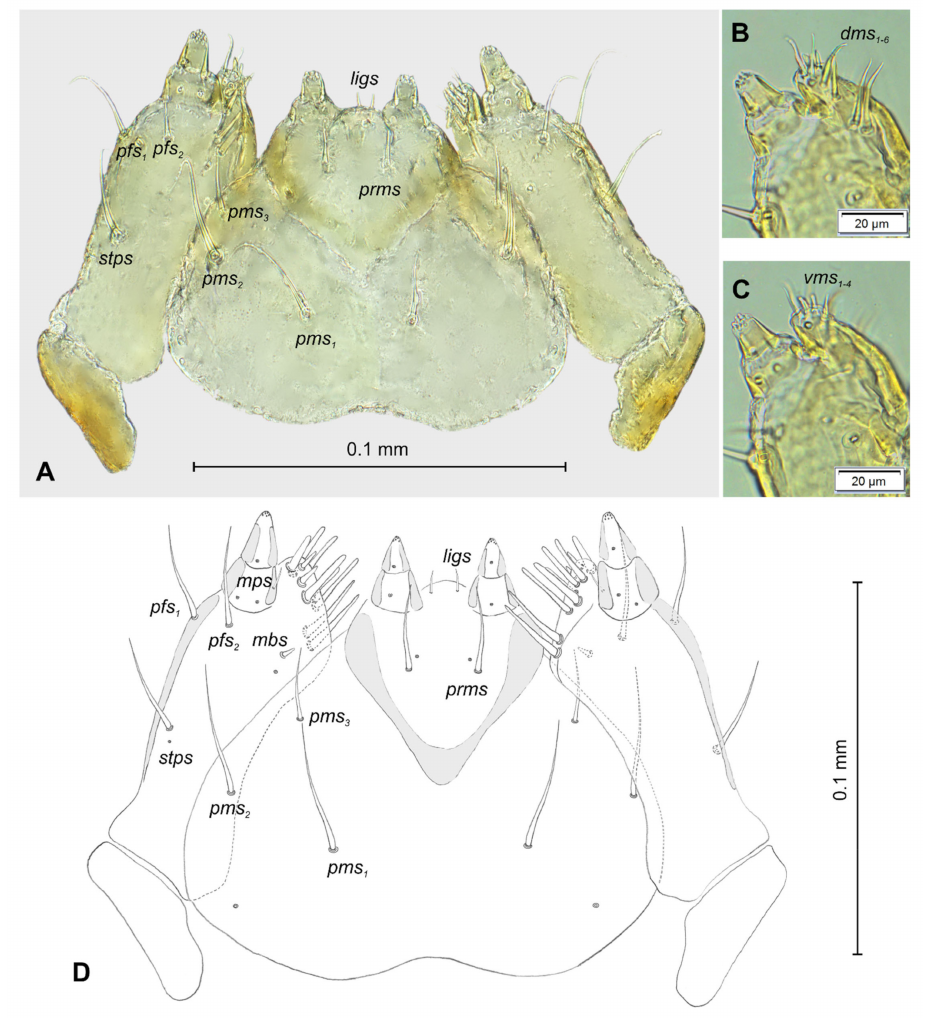
Figure 7. Lachnaeus crinitus mature larva, maxillolabial complex. ( A )—maxillolabial complex, ventral aspect, photo; ( B )— maxillolabial complex, ventral aspect, scheme; ( C )—apical part of right maxilla, dorsal aspect; ( D )—apical part of right maxilla, ventral aspect (setae: dms —dorsal malar, ligs —ligular, mbs —malar basiventral, mps —maxillary palp, pfs —palpiferal, Insects 2021 , 12 , x 11 of 26 prms —prelabial, pms —postlabial, stps —stipal, vms —ventral malar).